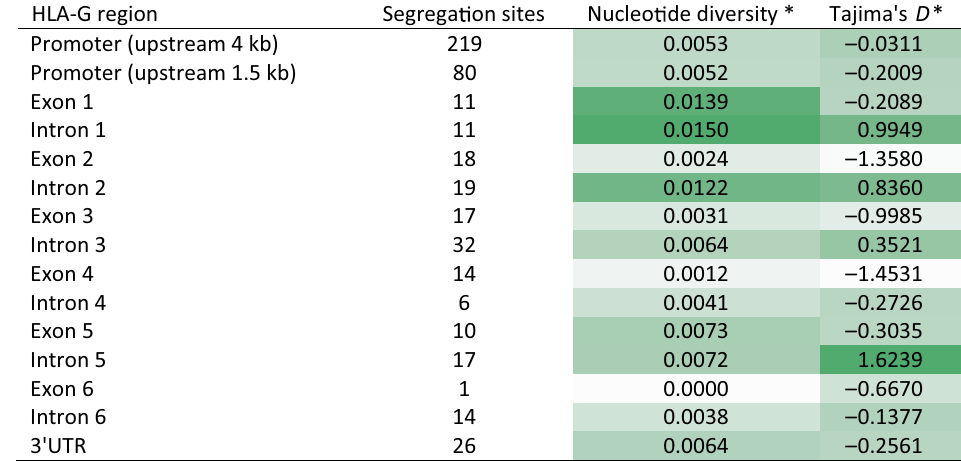
Table 2. The number of segregation sites, nucleotide diversity, and Tajima’s D across different HLA-G regions in 4640 samples from 88 different populations. *The indexes are scaled in shades of green, from white (the lowest value) to dark green (the highest value).